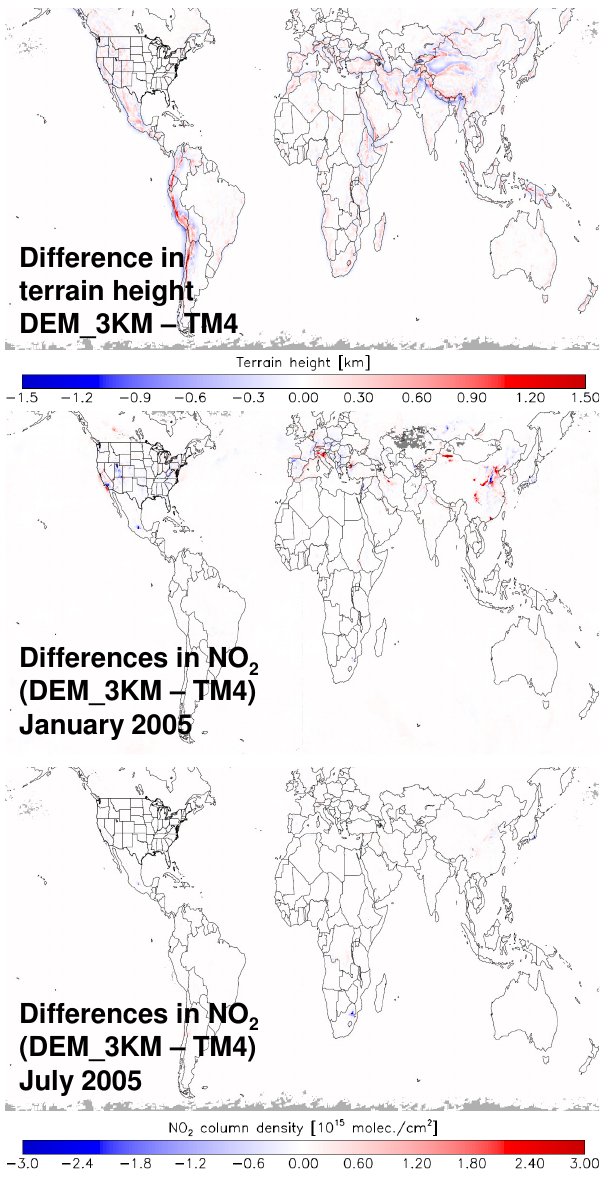
Fig. 2. Difference in terrain height calculated with the Global 3km Digital Elevation Model data (DEM 3km, upper panel). The middle panel indicates the differences in tropospheric NO 2 columns for January 2005 as calculated with the DEM 3km terrain heights and with the coarse TM4-derived heights as in v1.02. The lower panel indicates the differences for July 2005. Values are monthly means based on clear-sky (cloud radiance < 50%) observations).